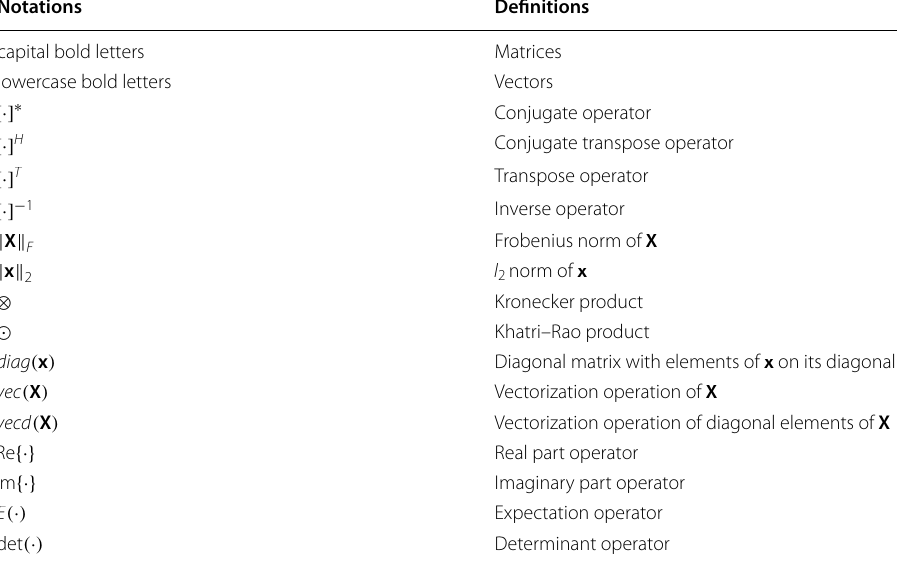
Table 1 Related